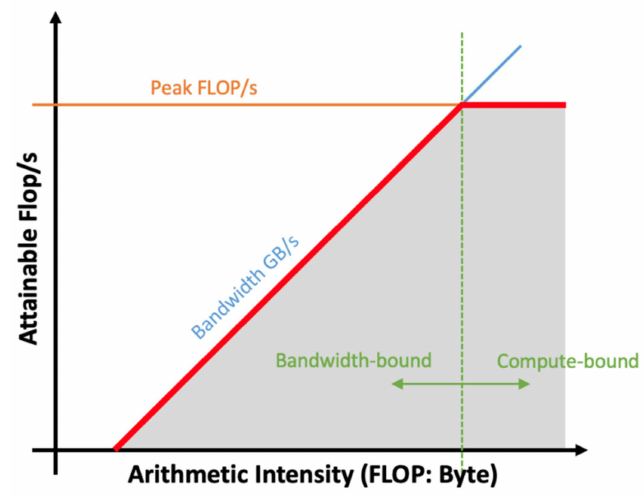
Figure 5. Roofline